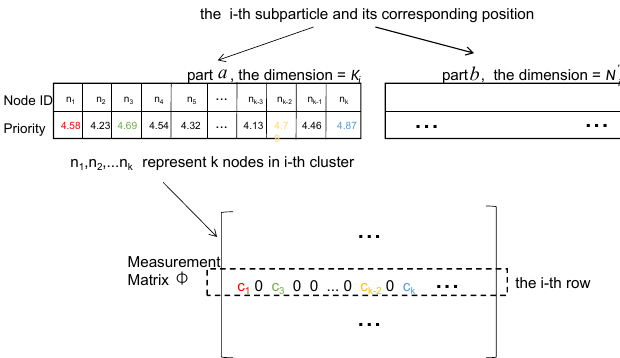
Figure 5. The demo for mapping part a of sub-particle i into Φ , where c j denotes random measurement